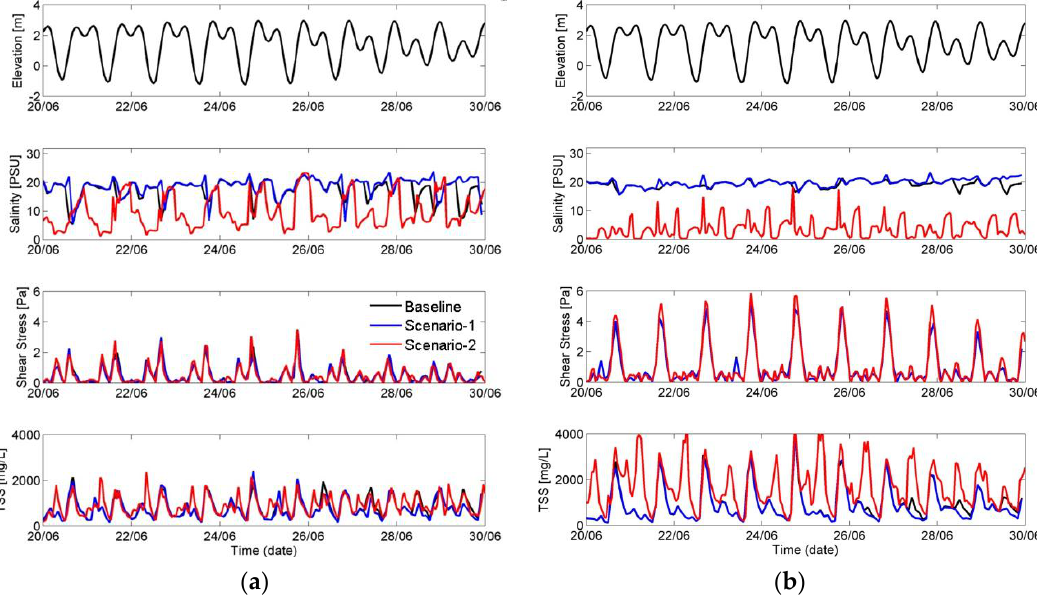
Figure 17. Comparison of time series of salinity, bed shear stress and TSS at ( a ) station A and ( b ) station B (Figure 2b) for baseline, Jetty Repair Scenario, SCN-1, and McGlinn Causeway restoration, SCN-2. Table 4. Percentage difference of two scenarios with the baseline for salinity, shear stress and TSS at two mooring stations. Salinity Shear Stress Bottom TSS Salinity Shear Stress Mooring Mooring